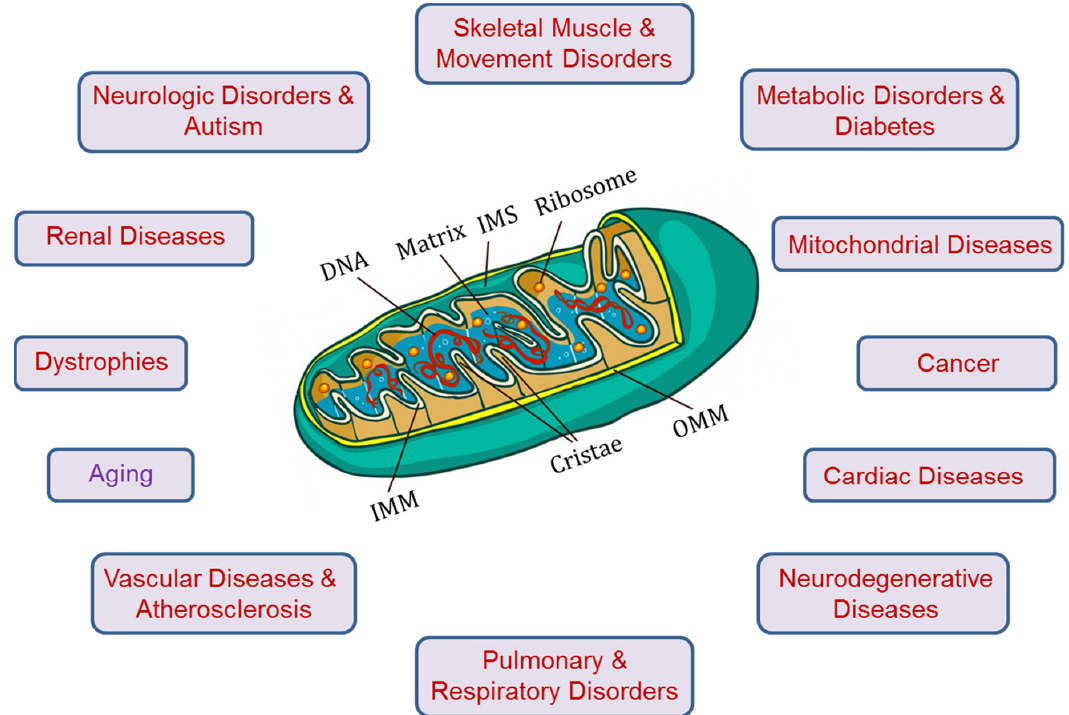
Figure 1. Mitochondria are involved in the pathogenesis of human diseases, and aging. IMM, inner mitochondrial membrane; IMS, intermembrane space; OMM, outer mitochondrial membrane.